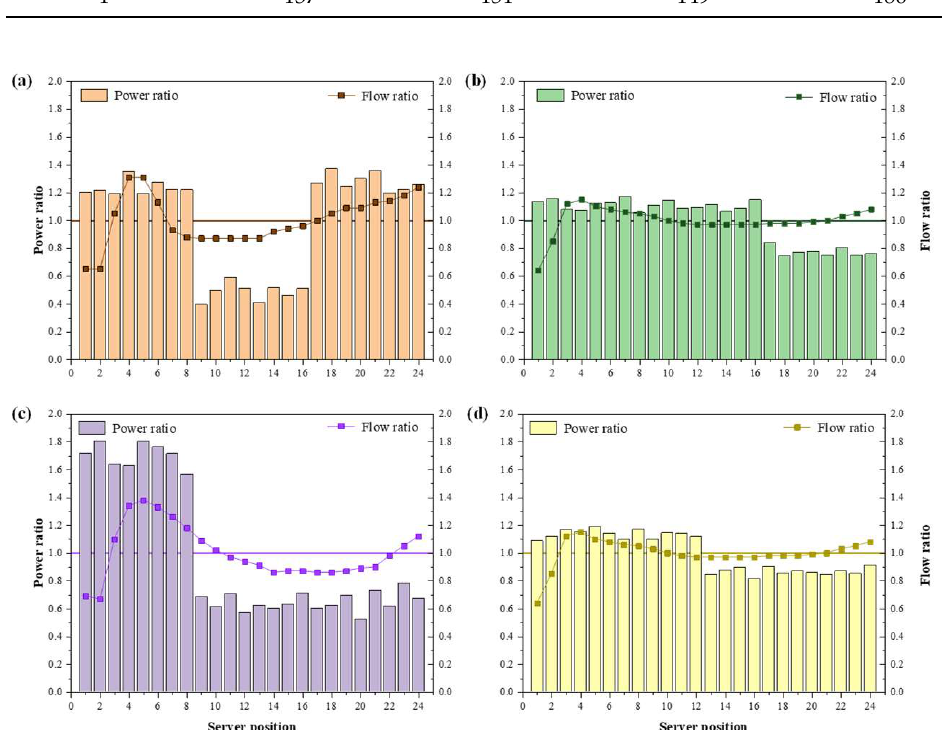
Figure 11. Power ratio and flow ratio of ( a ) F1, ( b ) F4, ( c ) F7, and ( d ) F10.